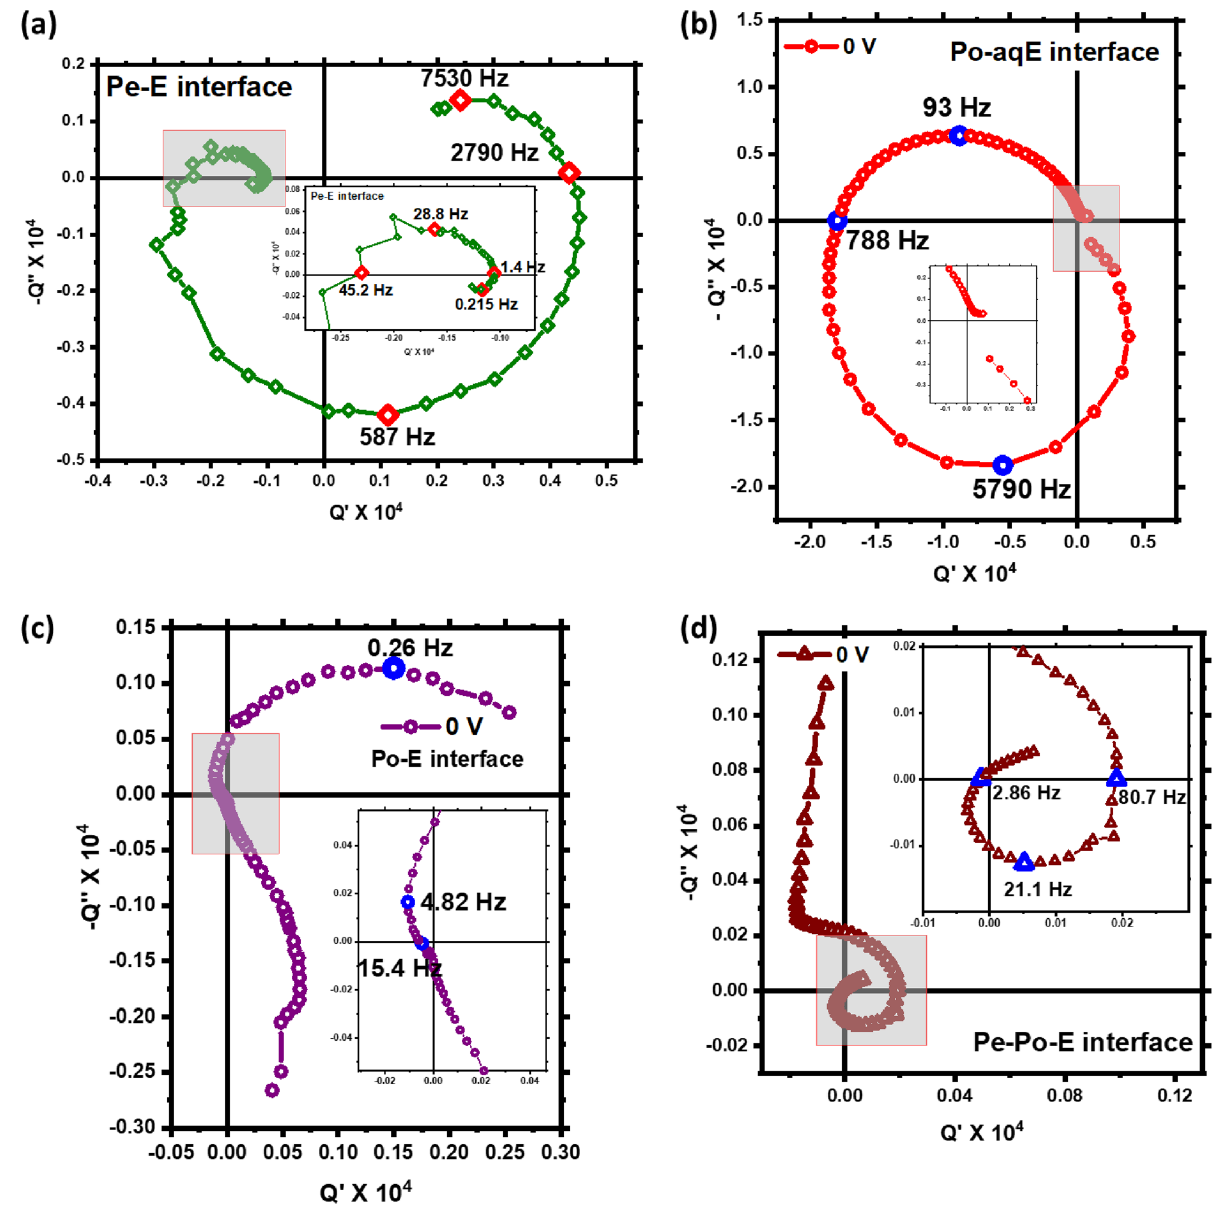
Figure 1. IMPS Nyquist plot of ( a ) Pe–E (perovskite–electrolyte interface), ( b ) Po–aqE (polymer–aqueous electrolyte interface), ( c ) Po–E (polymer–electrolyte interface) and ( d ) Pe–Po–E (perovskite–polymer– electrolyte